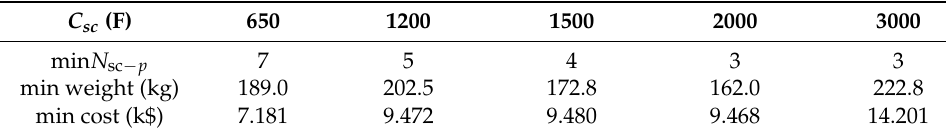
Table 7. Supercapacitors of different capacities matching results.